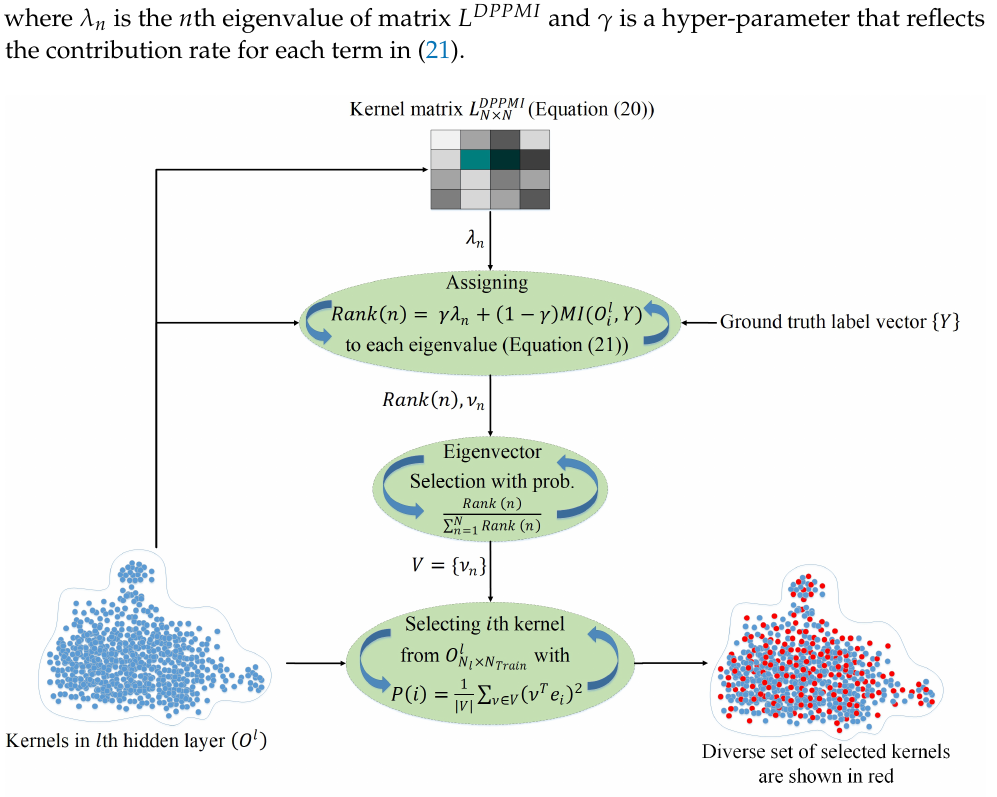
Figure 2. DPPMI dropout. Each point illustrates an extracted hidden kernel in the training set. Algorithm 3 shows the details of the DPPMI dropout approach. The proposed DPPMI dropout selects a diverse subset of kernels that are most relevant to the underlying clas- sification task. Our proposed approach constructs L DPPMI considering both Euclidean similarity and MI of latent kernels, and selects the kernels based on the eigenvalues of L DPPMI as well as the MI between each kernel with ground truth label